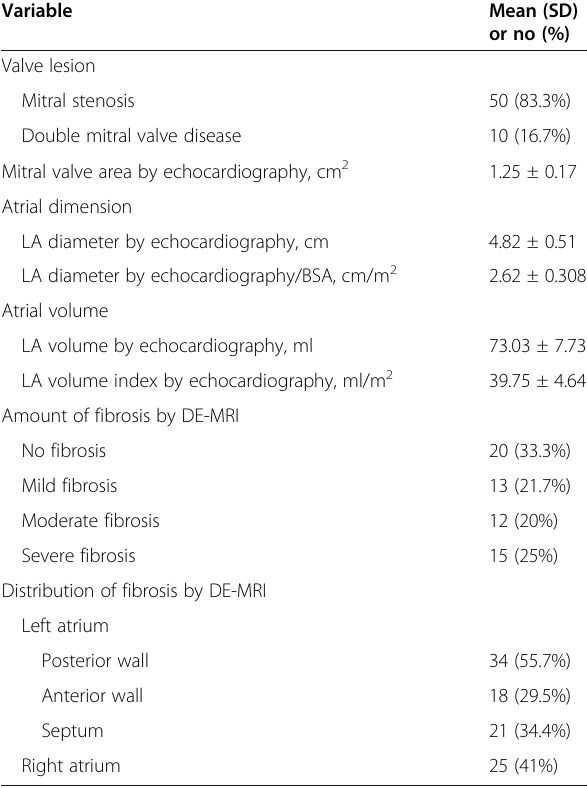
Table 2 Comparison between patients in sinus rhythm and those in